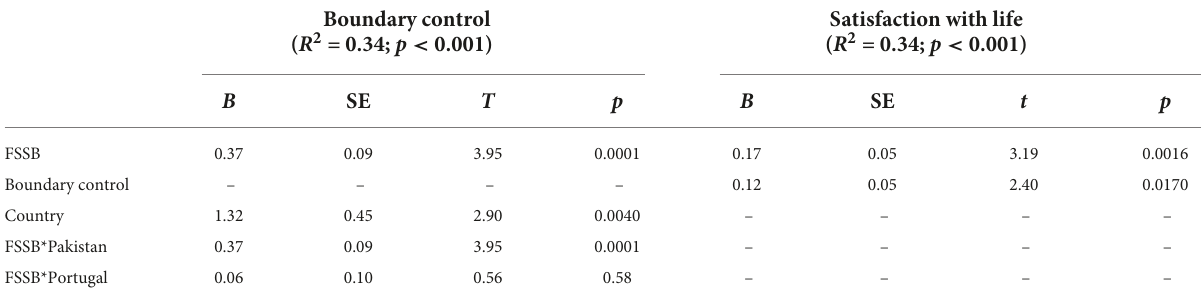
TABLE 2 Mediation and moderation analysis of studied variables ( N = 226).